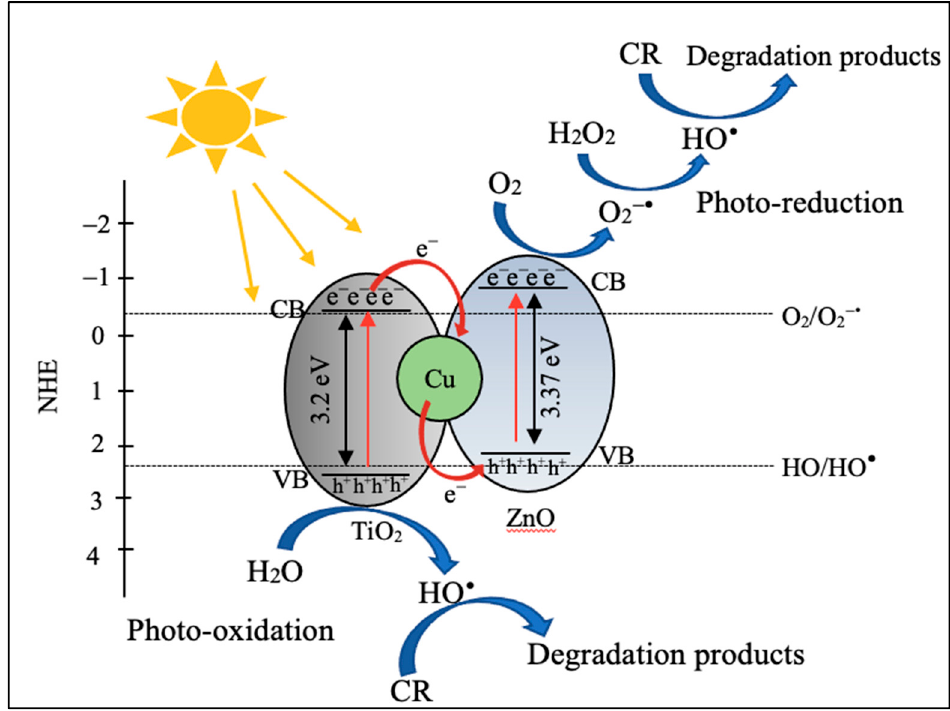
Figure 10. Charge transfer mechanism for Z-scheme Cu-ZnO/TiO 2 (CZT-2) heterojunction photocatalyst for CR degradation.